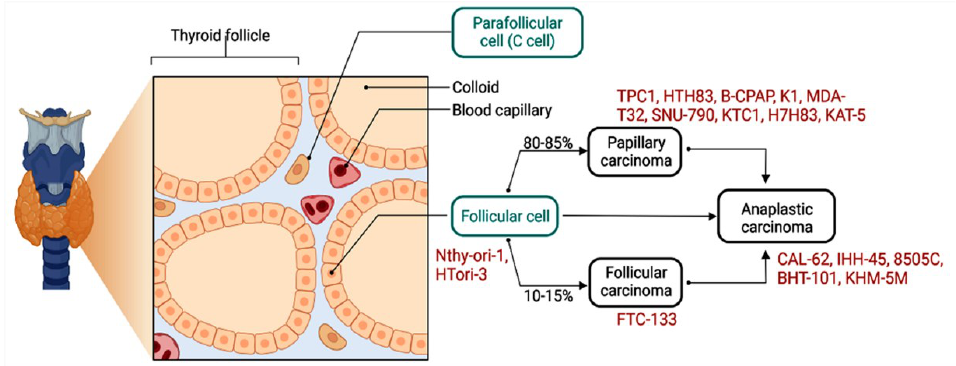
Figure 4. In vitro cell lines were used to study circRNA expression [126 – 129].